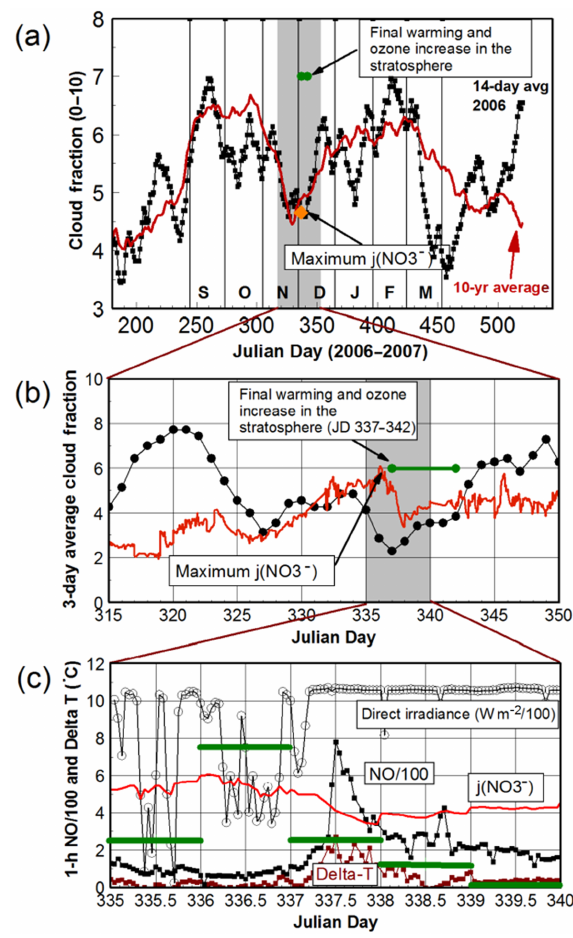
Figure 5. (a) Time series of observer-derived cloud fraction av- eraged for 2000–2010 (red line) at the SP and the field season of 2006–2007 (black line) showing the consistency of individual years with the long-term average. A 14 day running average (red line) was used. The period of final warming of the stratosphere in 2006 ( t 200hPa − t 300hPa > 0) and the period of rapid increase in to- tal column ozone are indicated symbolically for JD337–342. The date of the maximum in j (NO − ) is indicated by an orange dia- 3 mond (Day 336) from Davis et al. (2010). (b) The expanded time series of cloud fraction for JD316–350 showing relative minima on JD327 and JD337 as well as the timing for the breakdown of the ozone hole (as seen in j (NO − ) nitrate photolysis rate coefficients 3 scaled for plotting) and stratospheric warming. (c) Expanded view of NO, (cid:49)T (2–10m), j (NO − ) (scaled for plotting), and direct radi- 3 ance time series for JD335–340. Daily cloud fraction, derived from climatological observer records, is shown using green bars. Note the decrease in j (NO − ) prior to the increase in 3